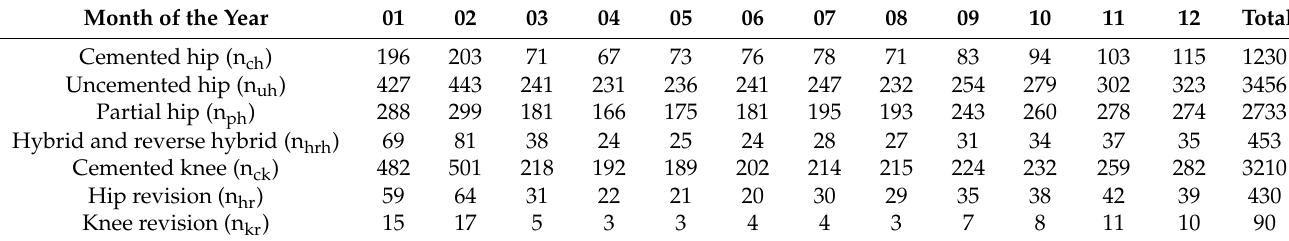
Table 3. Number of cases in 2020.